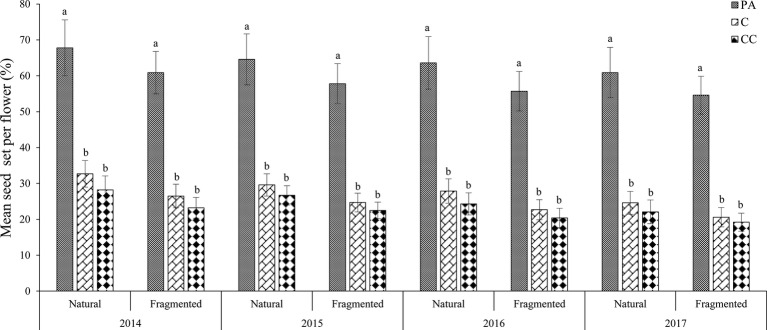
Mean seed set of H. ammodendron under the pollen limitation treatments in each year (from 2014 to 2017). Vertical bars denote the standard error. PA, pollen addition; C, control; CC, procedural control. Different letters show a significant difference at the 0.01 level.